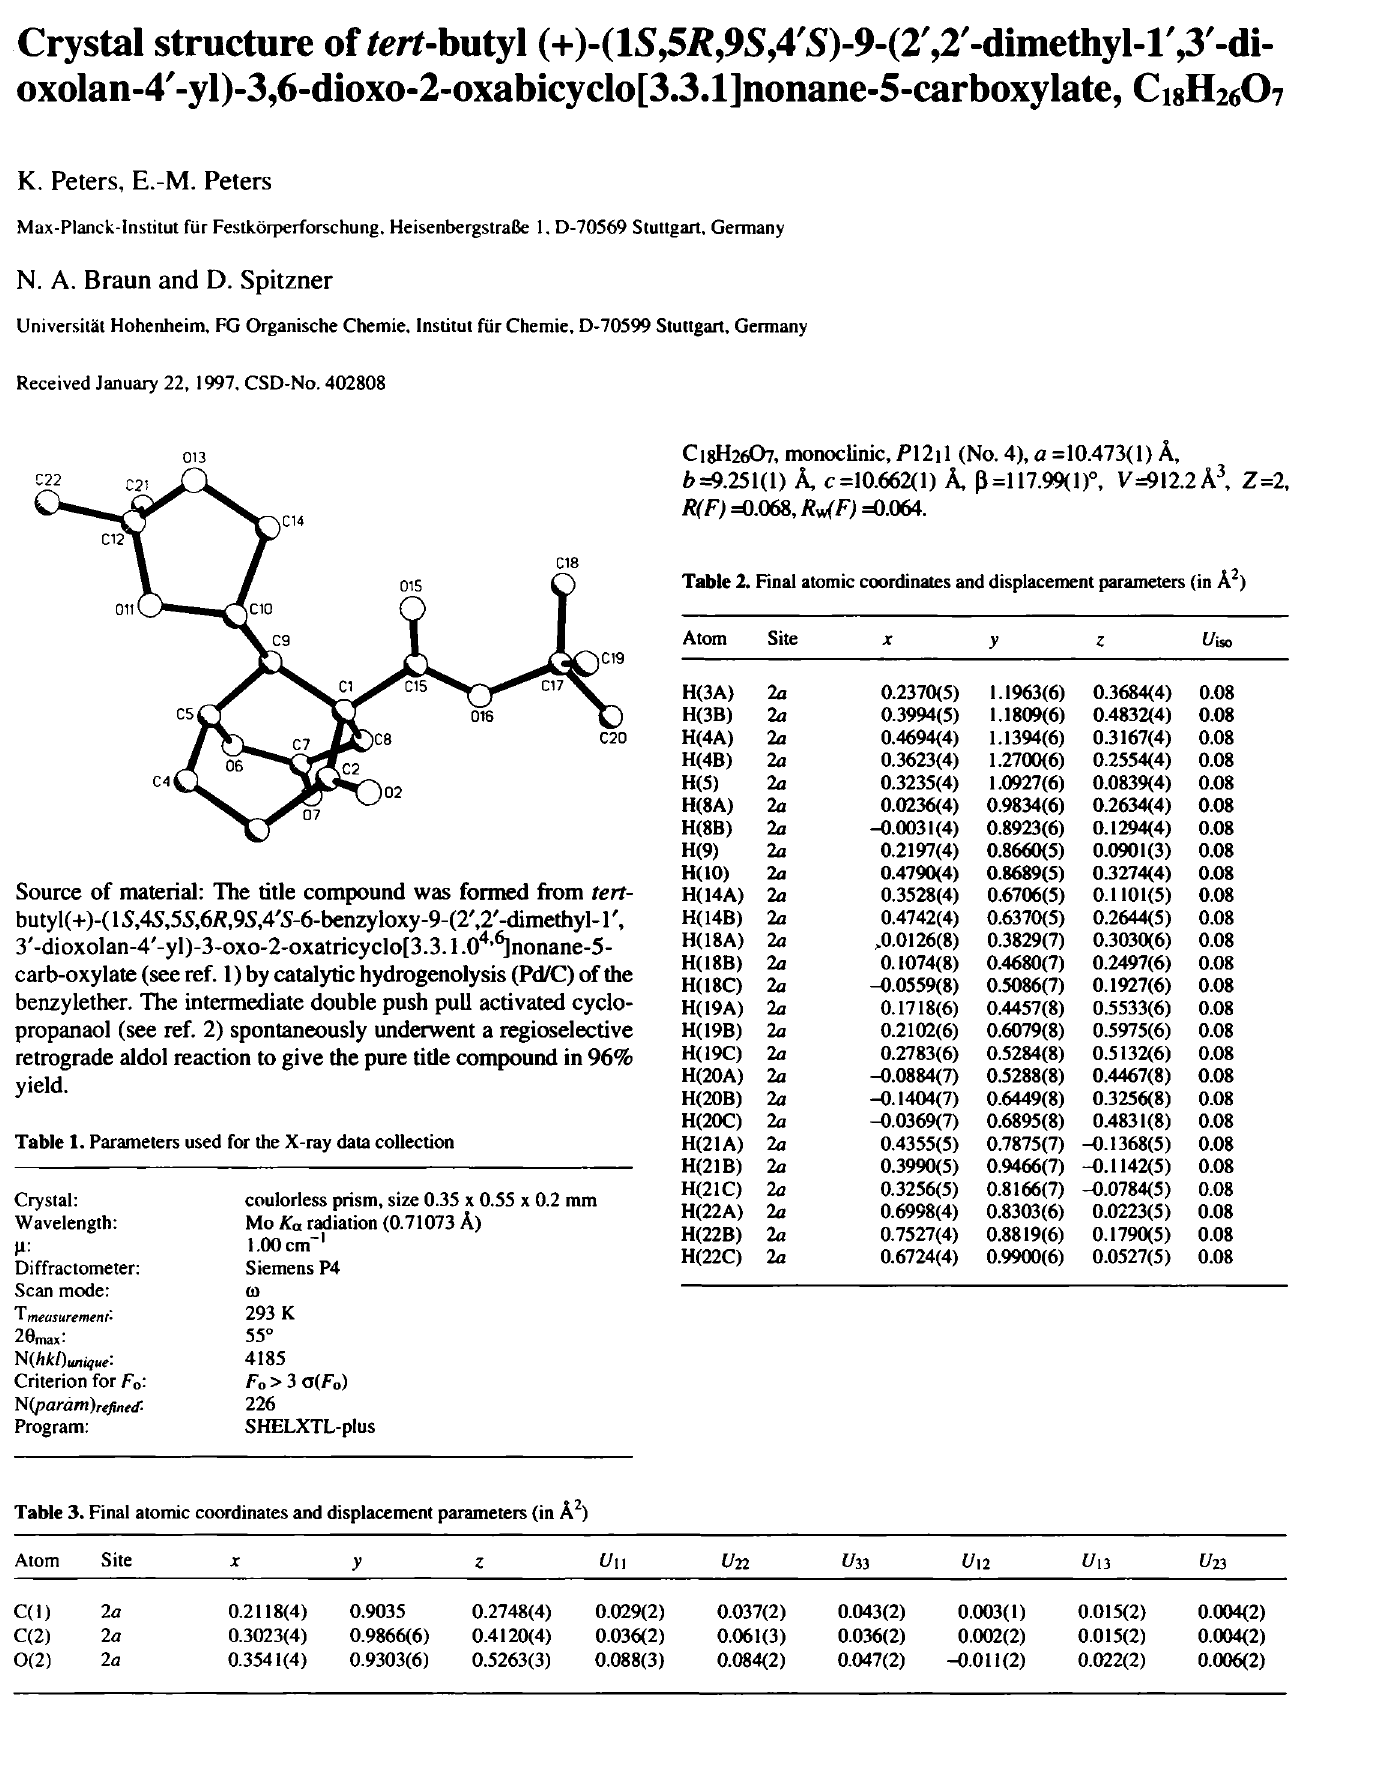
Table 3. Final atomic coordinates and displacement parameters (in Â^) Atom